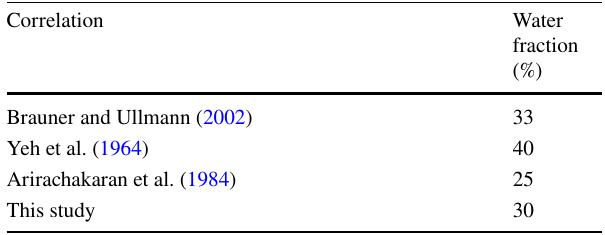
Table 2 Prediction of flow pattern transition point